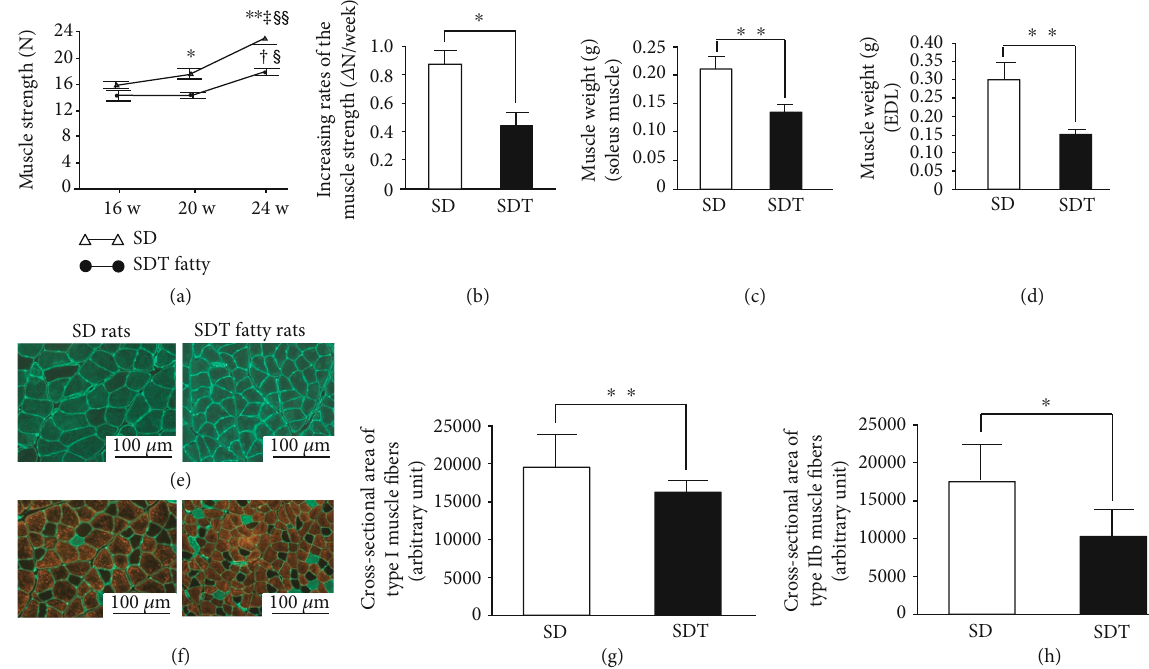
Figure 3: Evaluation of muscle strength, muscle weight, and muscle histological analysis. Change in muscle strength in SD and SDT fatty rats (a) and increasing rates of muscle strength (b). Weight of lower limb muscles in SD and SDT fatty rats. Soleus muscle (c) and EDL muscle (d) at 24 weeks of age. Multiple fl uorescent staining of soleus muscle fi bers (e) and semiquantitative assessment of type I fi bers in the soleus muscle (g). Multiple fl uorescent staining of EDL muscle fi bers (f) and semiquantitative assessment of type IIb fi bers in EDL muscle (h). Type I fi bers are stained green using antibodies against MyHCI and type IIb fi bers are stained red using antibodies against MyHCIIb. The frame of the fi bers stained green show laminin. Original magni fi cation: × 100. Values are presented as the mean ± SEM . ∗ p < 0 : 05 and ∗∗ p < 0 : 01 vs. SD rats at the same age; † p < 0 : 05 and ‡ p < 0 : 01 vs. the same group at 16 weeks of age; § p < 0 : 05 and §§ p < 0 : 01 vs. the same group at 20 weeks of